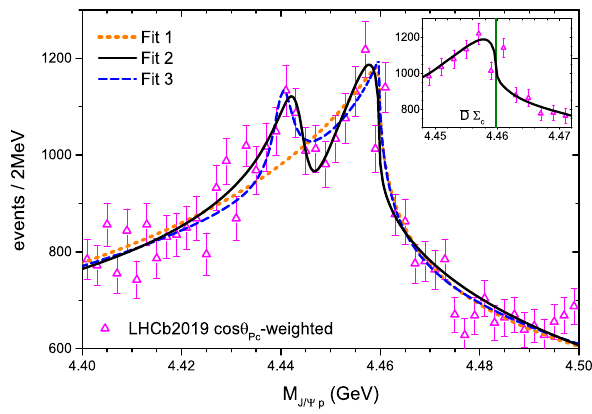
Fig. 2 Fit of the J /(cid:2) p spectroscopy of (cid:3) b → J /(cid:2) pK − for enlarged size around P c ( 4440 ) and P c ( 4457